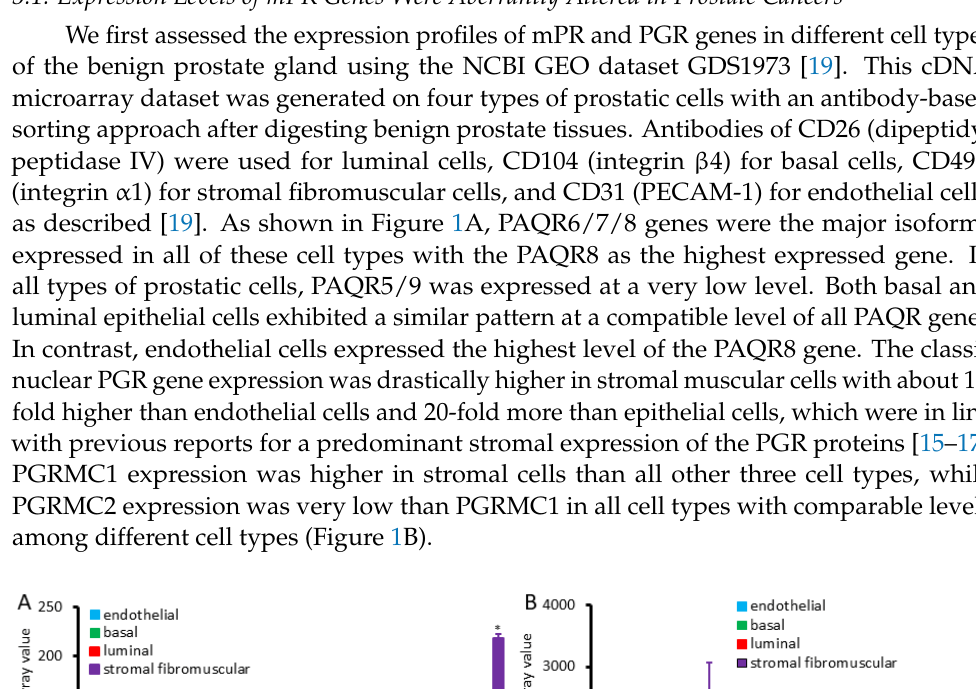
Figure 2. Aberrant expression of PAQR genes in prostate cancers. Gene expression levels were analyzed using the RNA- seq dataset from the TCGA project. Group comparison ( A , C ) and pair-wise comparison ( B , D ) were conducted in 499 or 52 cases, respectively. The p -values were derived from the Wilcoxon rank-sum test for group comparison or Wilcoxon signed-rank test for pair-wise comparison.